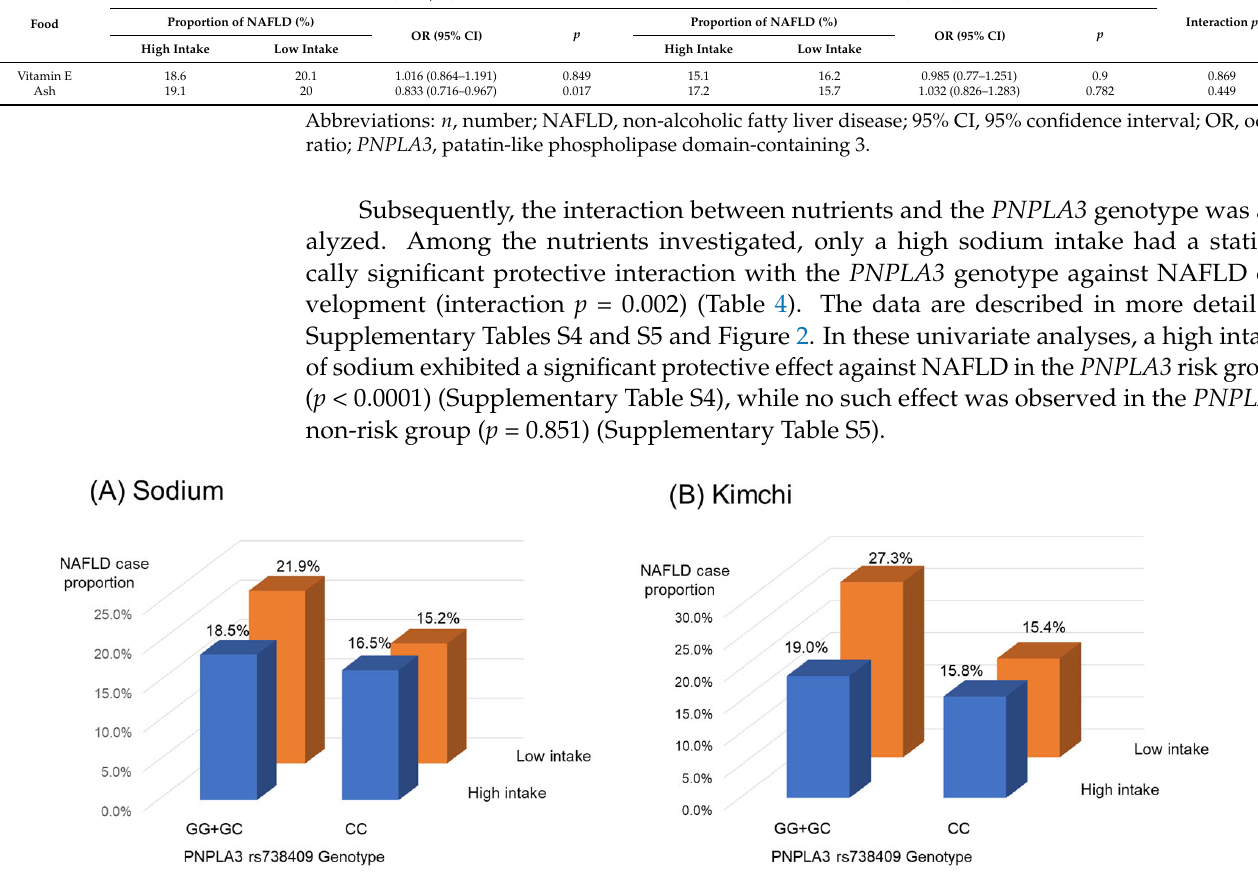
Figure 2. Impact of dietary sodium ( A ) and kimchi ( B ) intake on the genetic susceptibility of NAFLD. Abbreviations: NAFLD, non ‐ alcoholic fatty liver disease; PNPLA3 , patatin ‐ like phospho ‐ lipase domain ‐ containing 3.